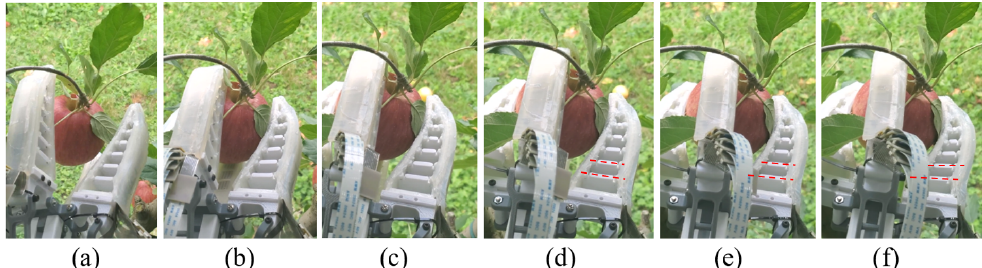
Figure 11. Slip detection and reaction motion sequence. ( a ) gripper arrived; ( b ) gripper closed; ( c ) gripper rotated; ( d ) slip detected; ( e ) motor-actuated finger reaction; ( f ) maximum grasping force